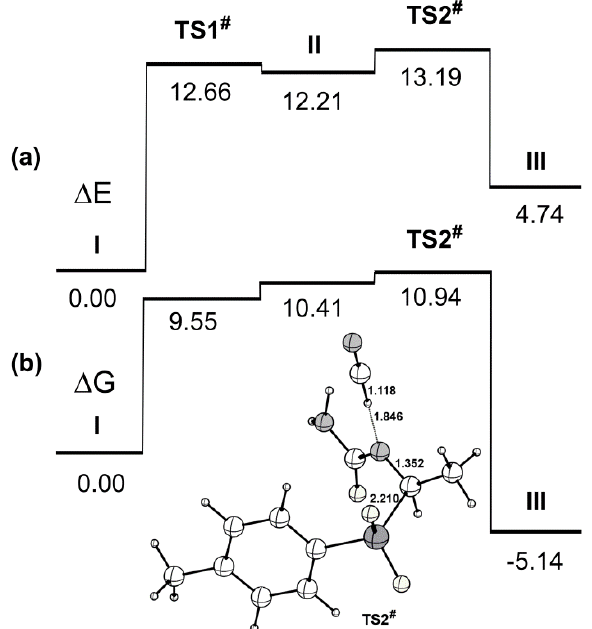
Figure 3. Calculated electronic ( a ) and Gibbs free energy ( b ) profiles for the transformation of 4j (conformer A ) into acylimine 7j under the action of cyanide-anion in DMF solution (1 atm, 298 K). The relative energies are given in kcal/mol. A view of the transition state TS2 # with selected bond lengths is presented.